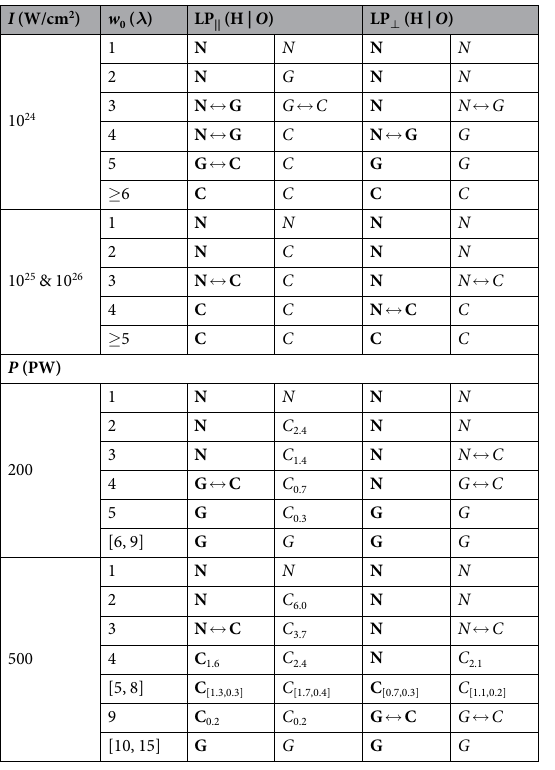
Table 1. Seeded QED cascade regimes. Results are reported for aligned (LP || ) and orthogonal (LP ⊥ ) linear polarization and either for hydrogen (H, bold left) or for oxygen (O, italic right). Symbols are as follows: N = No indicate the average cascade growth rate 〈 Γ 〉 in units of T − 1